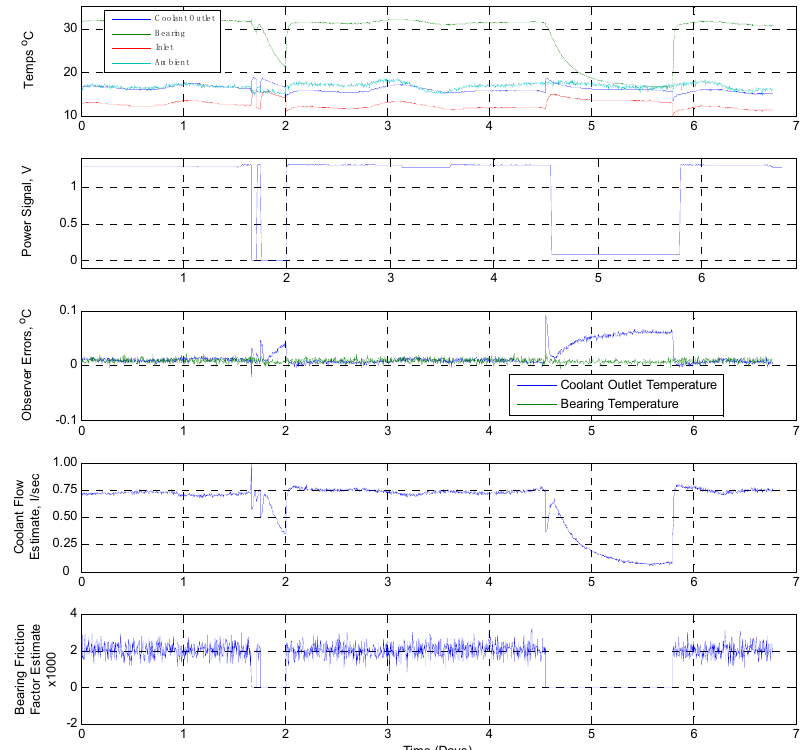
Figure 15. Online edge device implementation site trials results data: Pump 3 (fixed speed).